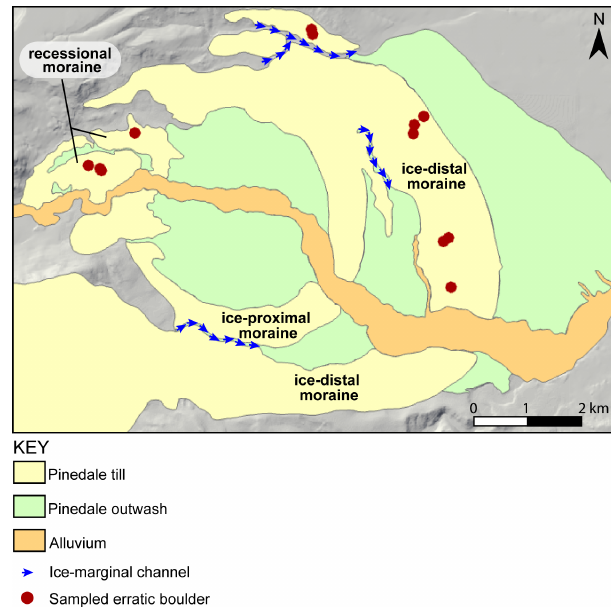
Figure 4. Surficial geologic map of the Cut Bank Creek moraine complex detailing the Pinedale ice-distal, ice-proximal, and reces- sional moraine